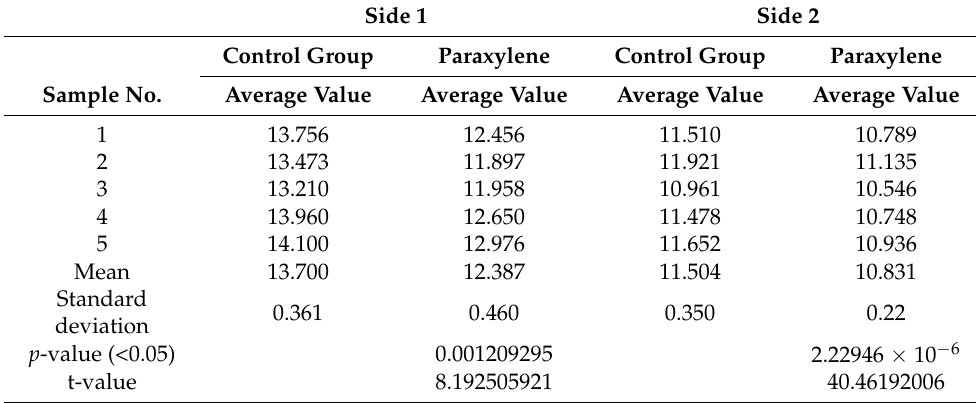
Table 3. Roughness values (Ra) for the PA 2200 samples manufactured at 4.5